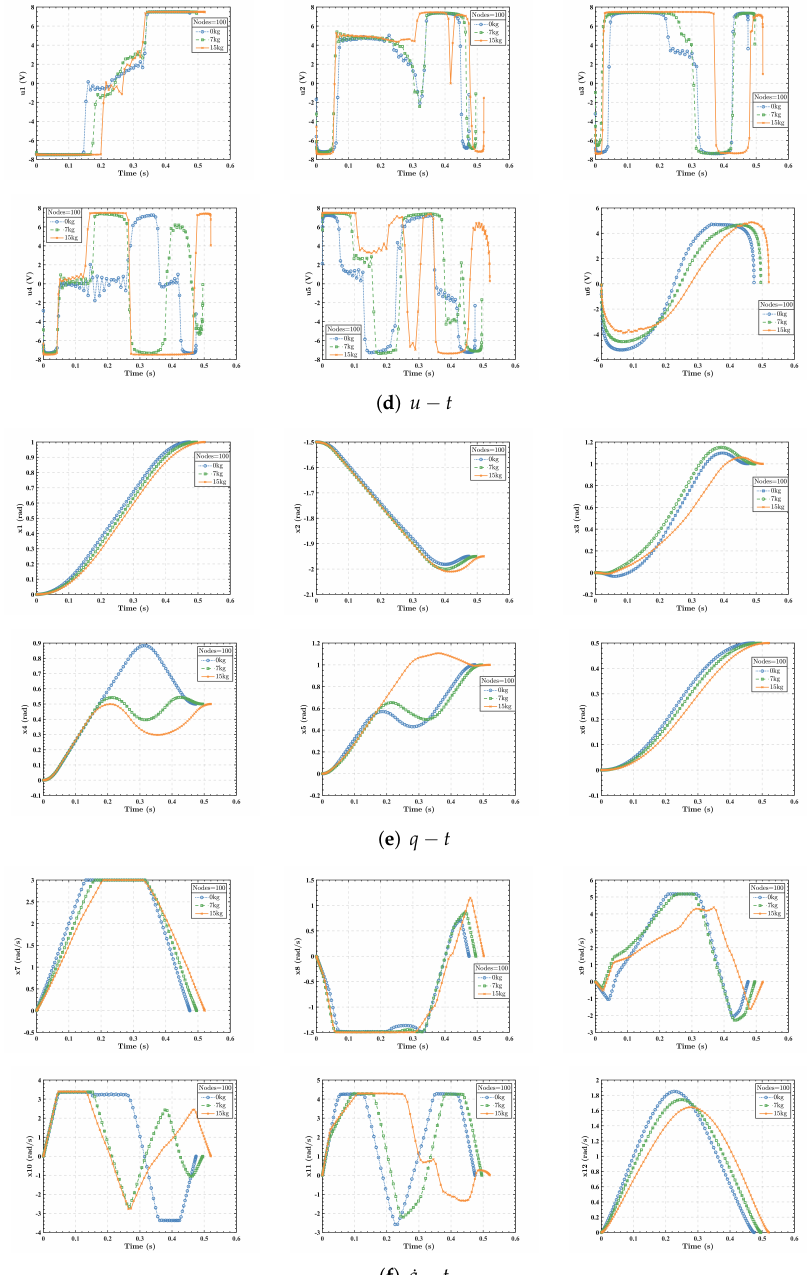
Figure 5. The solutions of the R3M1. Subgraphs ( a – c ) are the solutions using LPM method with 20 nodes; subgraphs ( d – f ) are the solutions using LPM method with 100 nodes. Subgraphs ( a , d ) and print the curve of the input voltage of joint actuators. Subgraphs ( b , e ) print the curve of the joint positions. Subgraphs ( c , f ) print the curve of the joint velocities. The blue curves with circles ( − o − ) refer to the solutions with 0 kg load. The green curves with squares ( − (cid:3) − ) refer to the solutions with 7 kg load. The orange curves with crosses ( − x − ) refer to the solutions with 15 kg